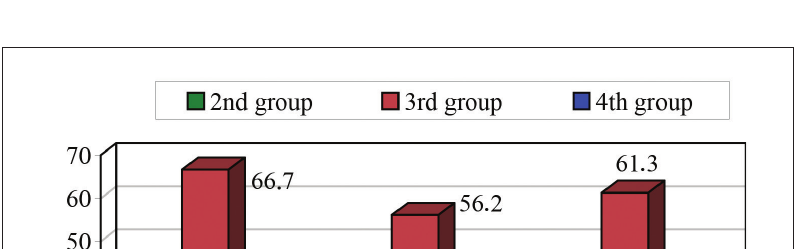
Figure. The distribution of bioenergy groups among 9–10-year-old